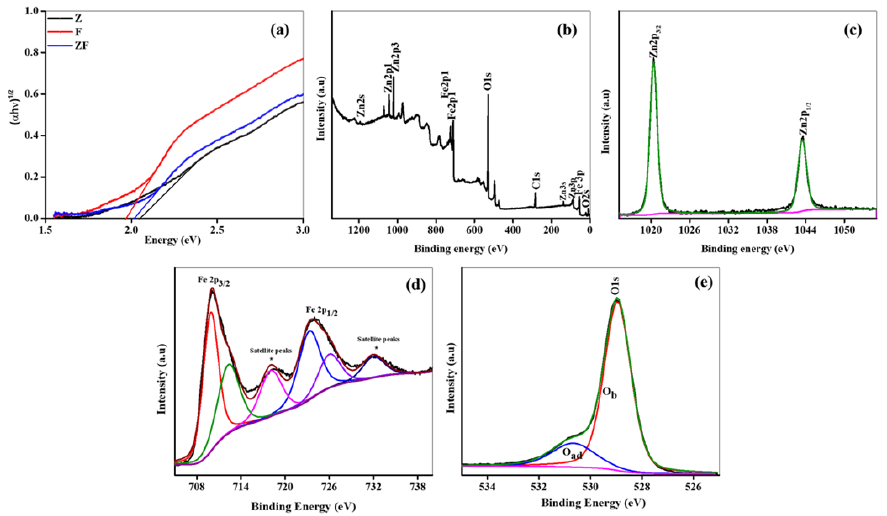
Figure 5. Optical properties of ( a ) bandgap plots, ( b ) XPS survey spectra of ZnFe 2 O 4 -Fe 2 O 3 (ZF) nanostructures, ( c ) Zn2p spectra, ( d ) Fe2p spectra, and ( e ) O1s spectra.